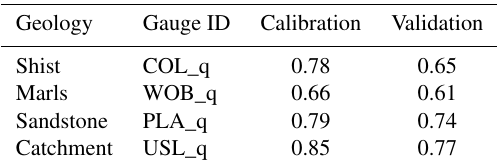
Table A5. Gauge-specific performance measures (Nash–Sutcliffe efficiency of discharge) of the SHM Attert in the calibration and validation period. Gauge locations are shown in Fig. 2; catchment sizes in Table